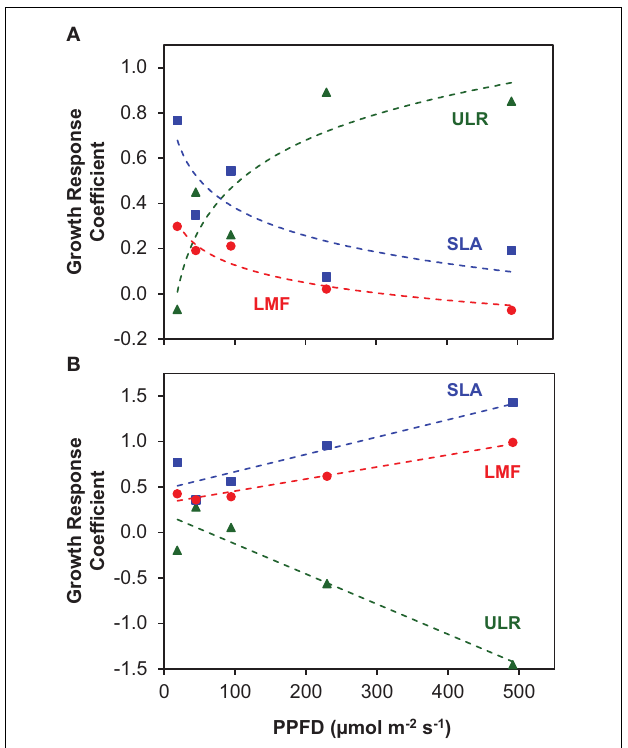
FIGURE 6 | The Growth Response Coefficients (GRC), showing the contribution of variation in the components ULR, SLA and LMF to variation in RGR for interspecific comparisons at each growth irradiance (PPFD). (A) All species included in the analysis; (B) analysis for the three shade-intolerant species only. The regression coefficients of log-transformed ULR, SLA and LMF on log-transformed RGR at each growth irradiance represent the GRC’s.